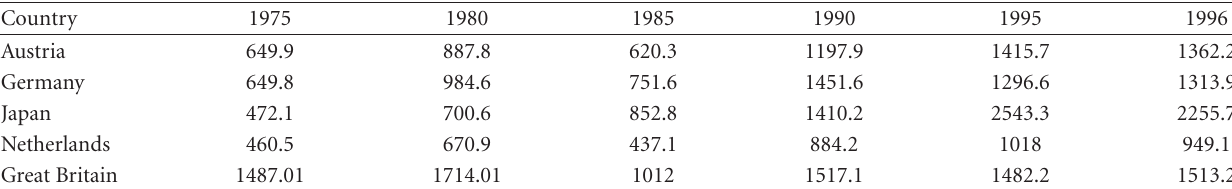
Table 7: Statistics of FFP in other countries during recent years (Unit: